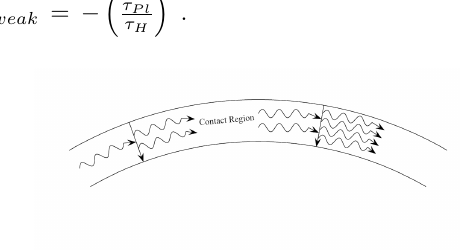
Figure 1: The stimulated emission of gravitons in a